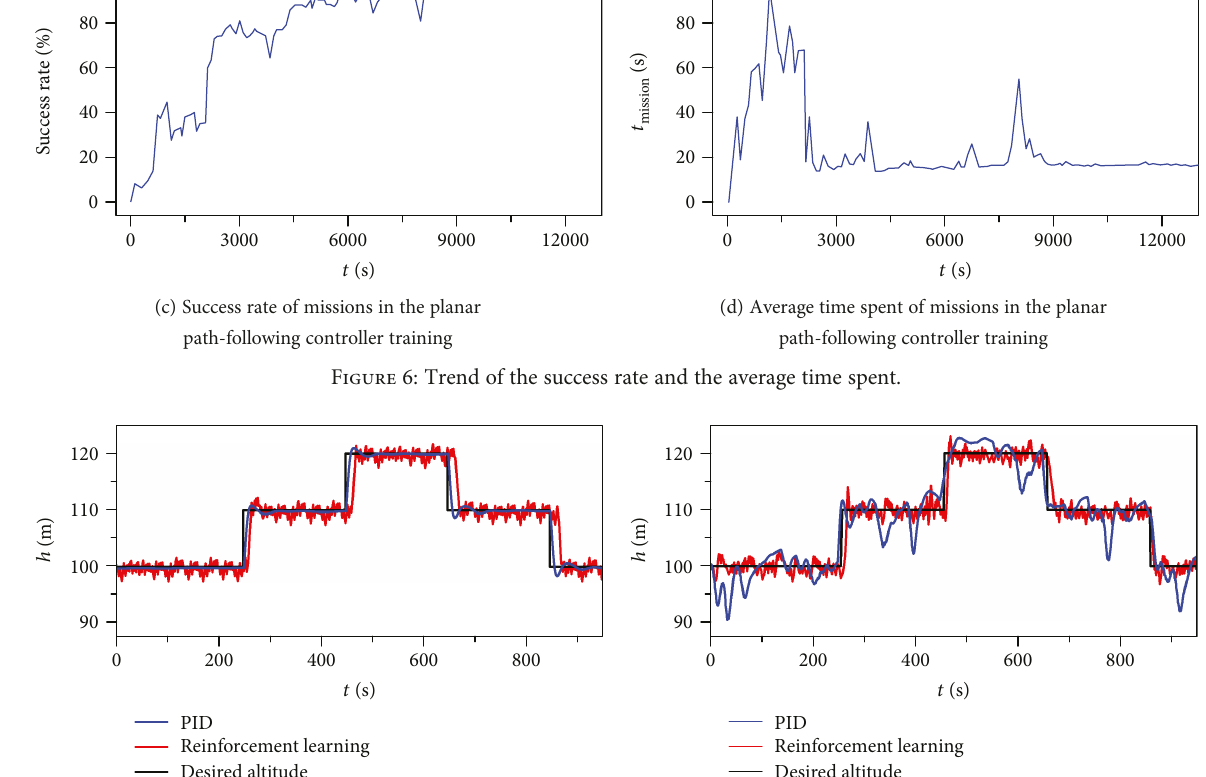
Figure 7: The airship altitude